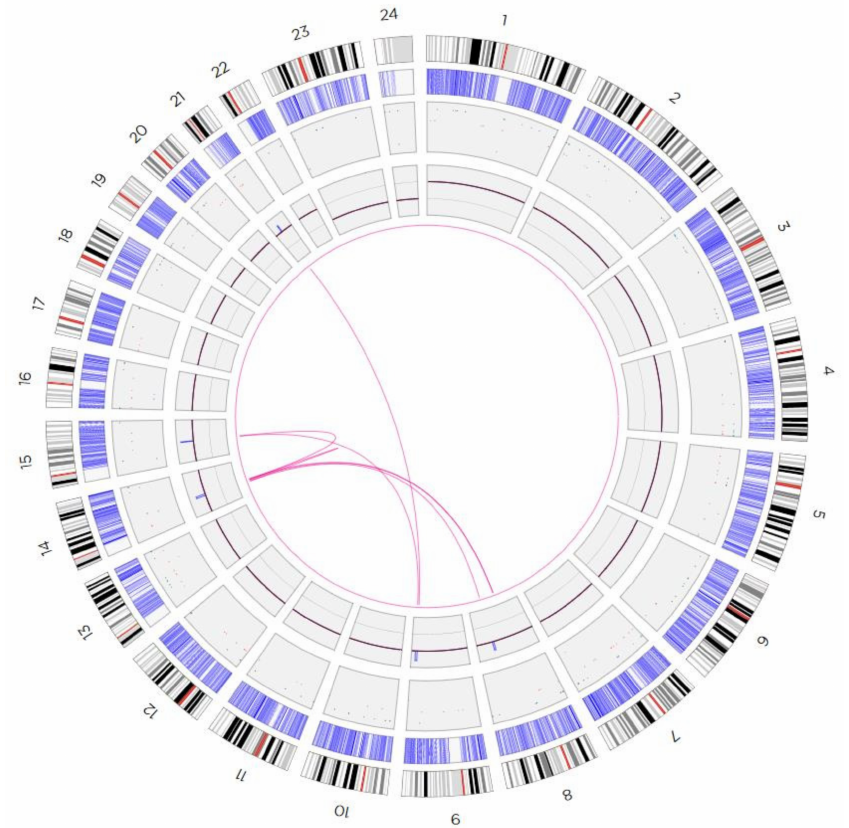
Figure 3. Circos plot depiction of the optical mapping results, showing the interconnections between involved chromosomal regions on the presented